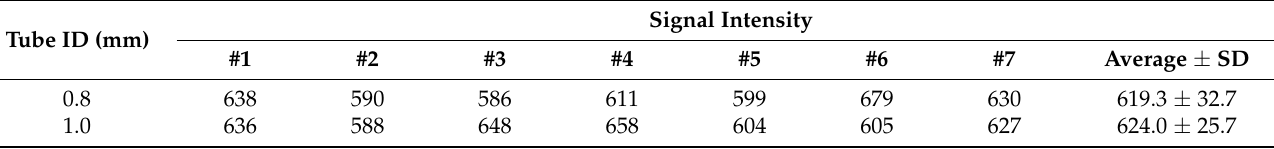
Figure 4. Microvascular phantom images for the reproducibility of the flow system. A coronal maximum intensity projection (MIP) image in the 0.8 and 1.0 mm tube diameters is provided for reference (left). ( a ) Seven axial MIP images of the 0.8 mm tube and ( b ) 1.0 mm tube. Table 5. Average signal intensity of seven PC 2D MRA images. Tube ID (mm)